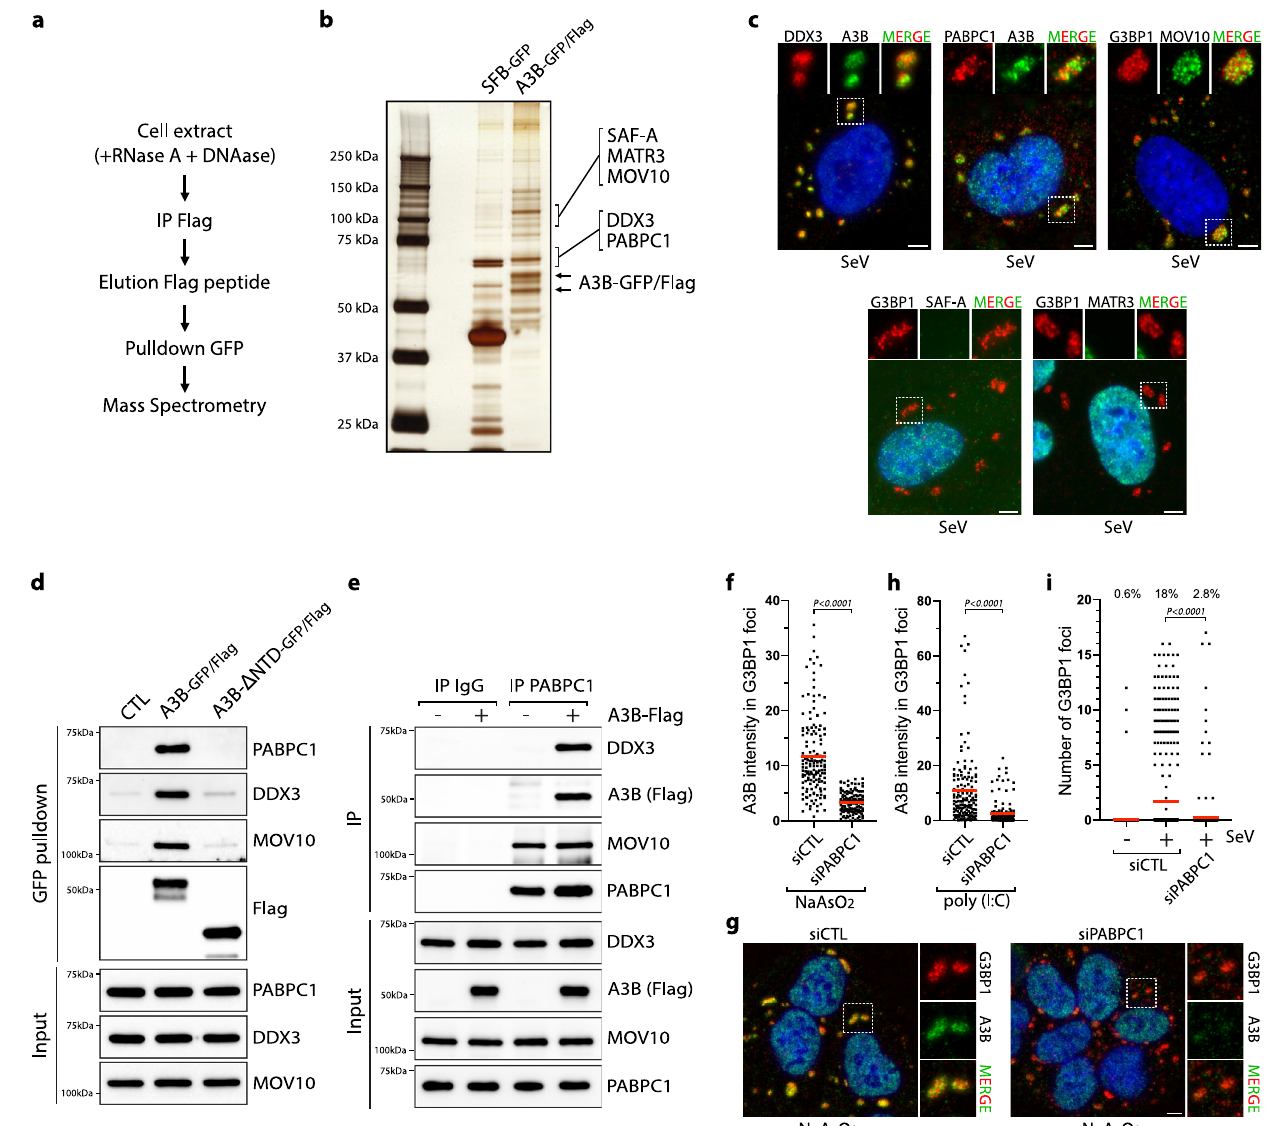
g Immuno fl uorescence for A3B (Flag) and G3BP1 in U2OS-A3B- fl ag cells + DOX transfectedwithsiCTLorsiPABPC1for40handtreatedwithNaAsO2(500 µ M,1h). Scale bar: 5 μ m. h Quanti fi cation of A3B intensity (arbitrary units) in G3BP1 foci in U2OS-A3B- fl ag cells treated with DOX, transfected with a siRNA control (CTL) or againstPABPC1for40h,andthentransfectedwithpoly(I:C)(200ng/mL,16h).Red lines indicate the mean (Number of G3BP1 foci, n =150). P -values were calculated withatwo-tailed Welch t -test. i Quanti fi cationof thenumberofcytoplasmicG3BP1 focibycellinindividualU2OScellsknockeddownforPABPC1andinfectedwithSeV (MOI=1, 24hpi). Top; percentage of cells with G3BP1 foci. Red lines indicate the mean(Numberofcells, n =500). P -valueswerecalculatedwithatwo-tailedWelch t - test. Source data are provided as a Source Data fi